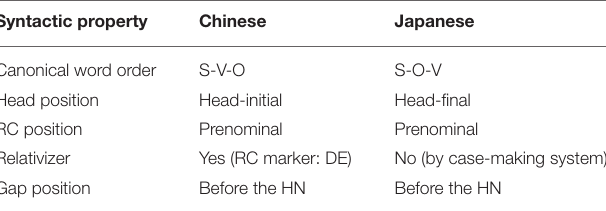
TABLE 1 | Comparison of syntactic properties between Japanese and Chinese. Syntactic